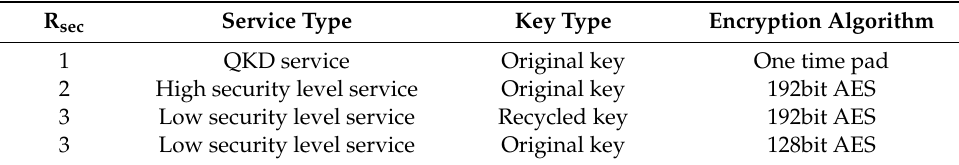
Table 2. Characteristic of Service.